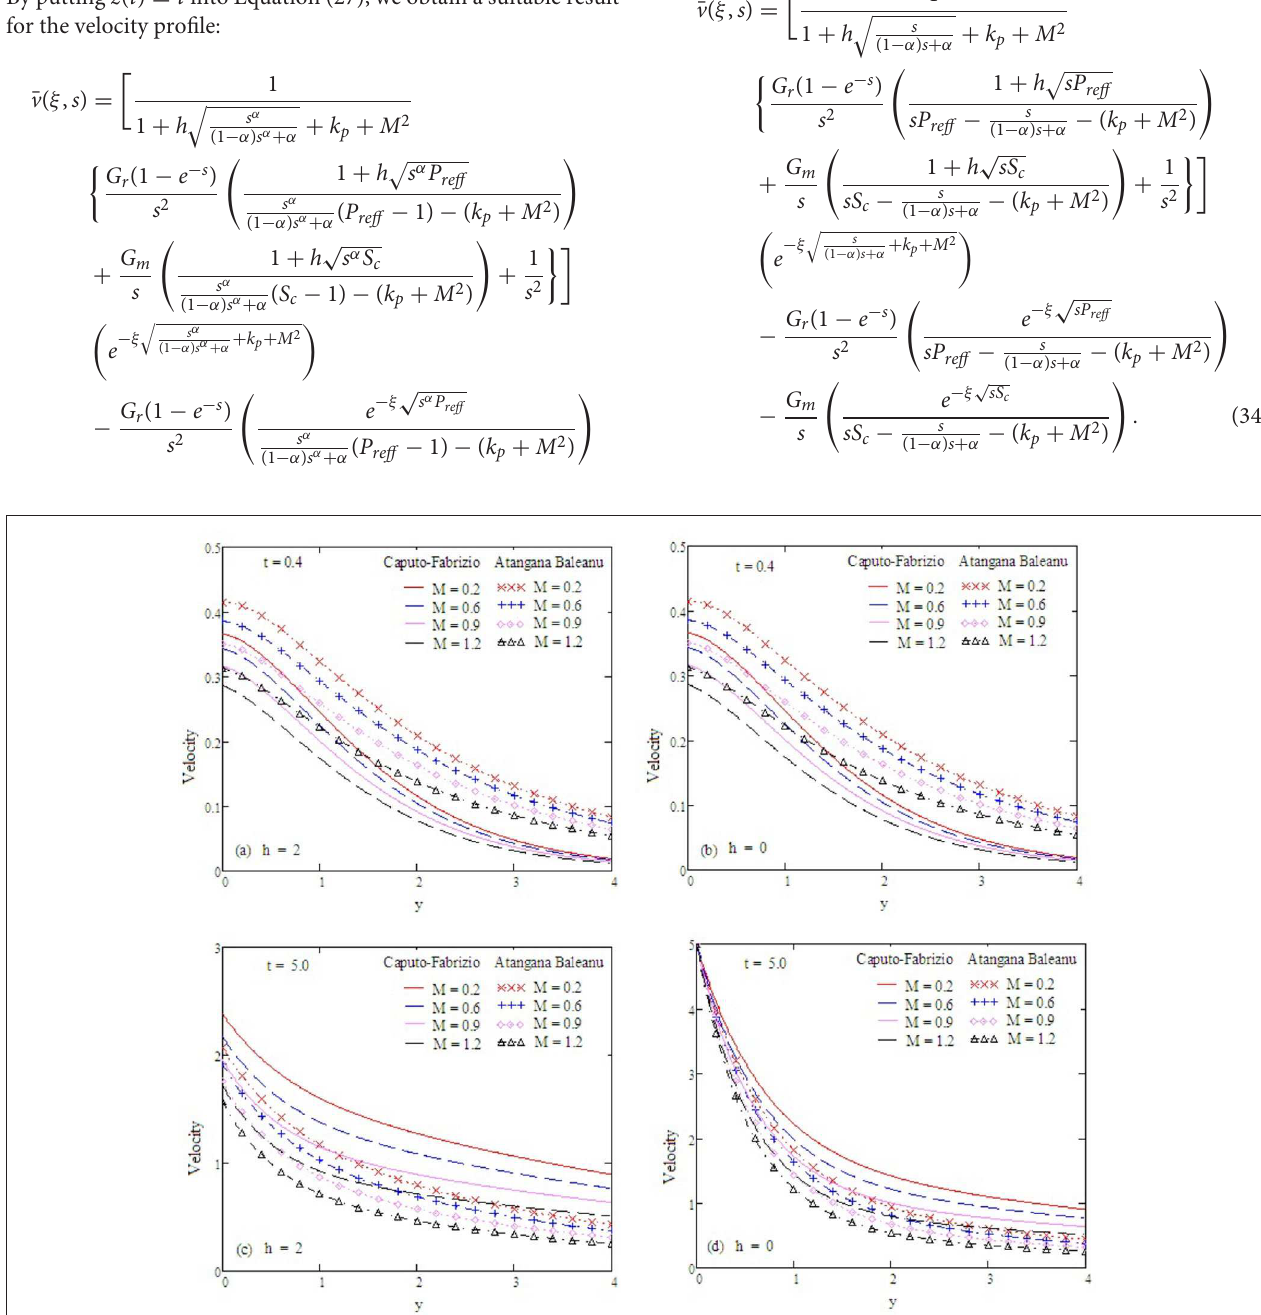
FIGURE 8 | Velocity profiles with altered values of M and other parameters are α